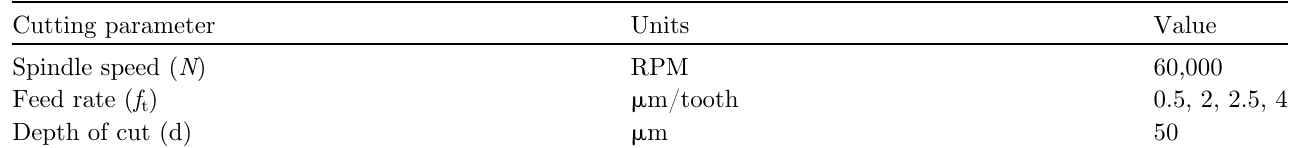
Table 4. Cutting parameters used for micro end milling.